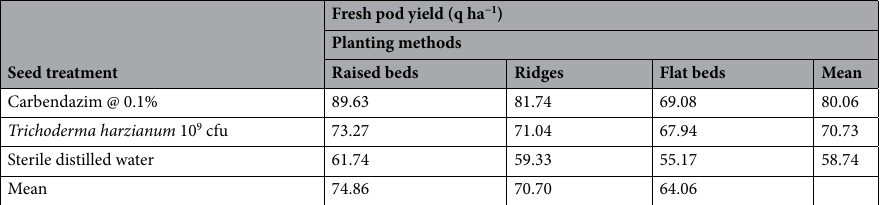
Table 6. Effect of seed treatment and planting methods on fresh pod yield (q ha −1 ) of root rot of pea under field conditions. C.D ( p ≤ 0.05). Planting method (M): 0.726. Seed treatment (S): 0.726. (M × S):